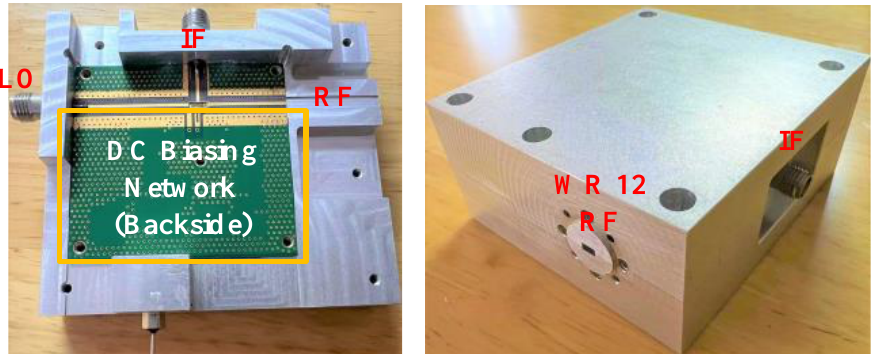
Figure 11. Photo of the 66–67 GHz channel emulator module integrating the RF transceiver chip, the microstrip-to-waveguide transition structure, and the DC biasing network.